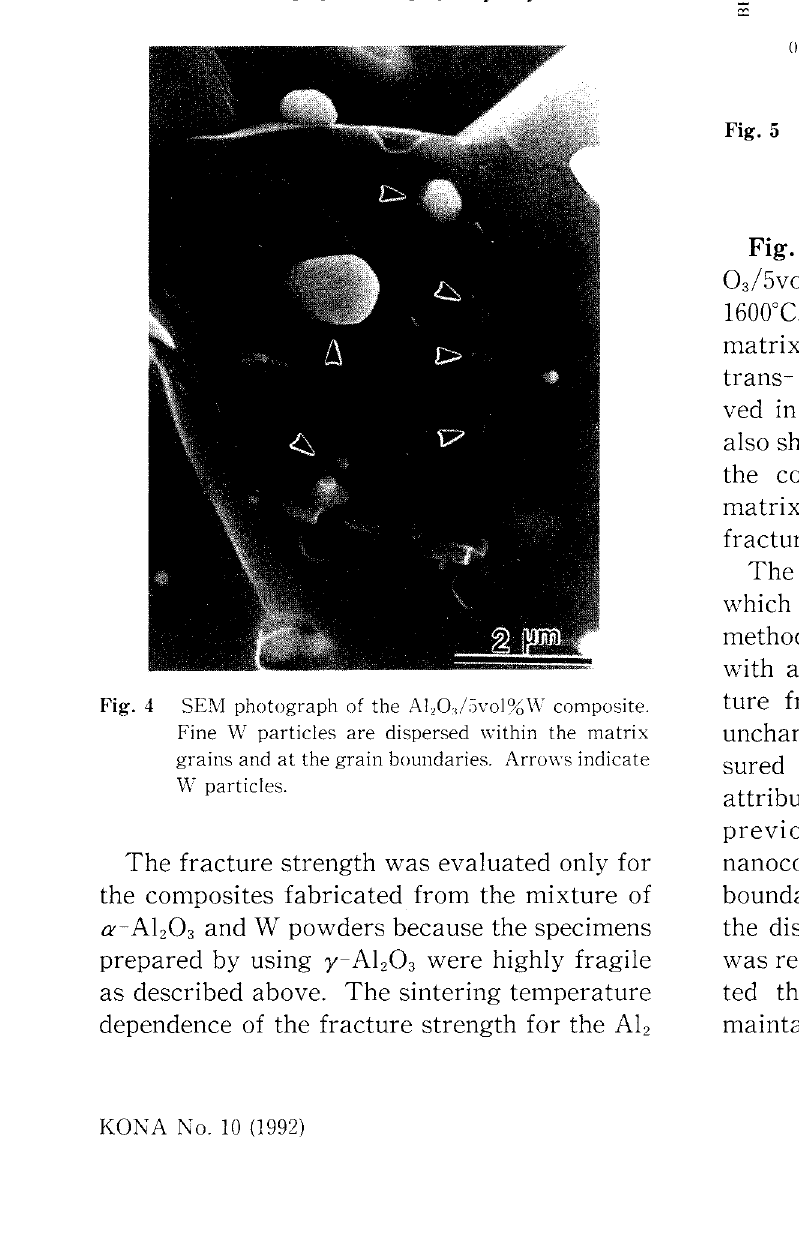
Fig. 5 Variation of fracture strength with sintering tem perature for Al,0,/5vol%W